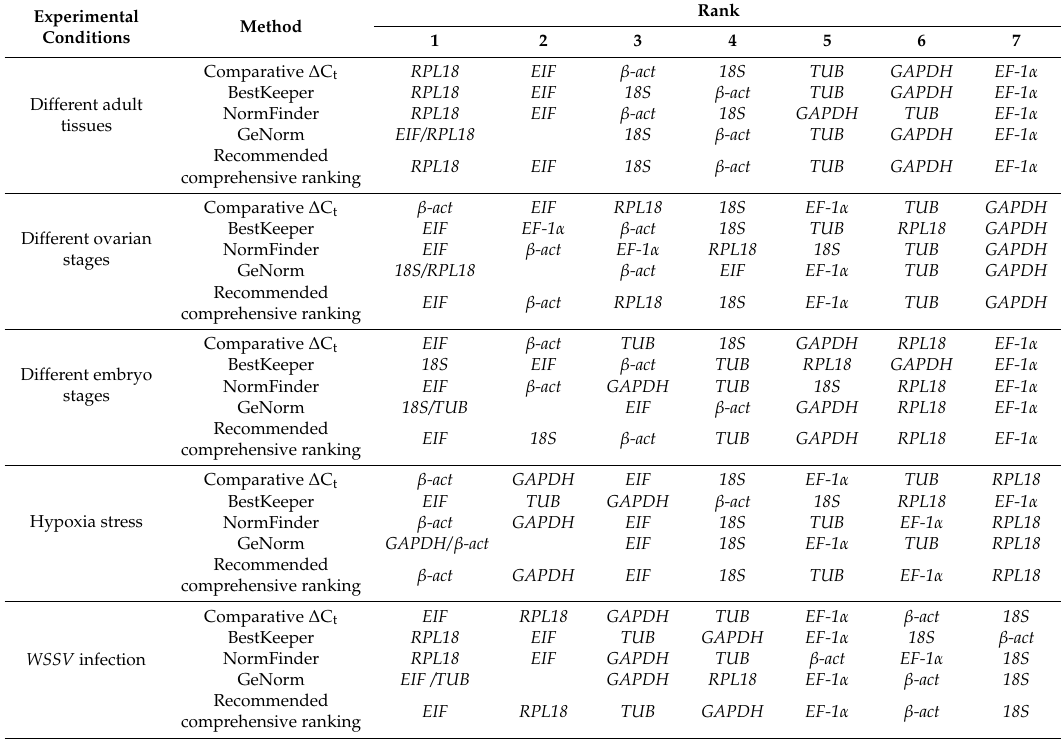
Table A2. Ranking of reference genes under different conditions by different methods.